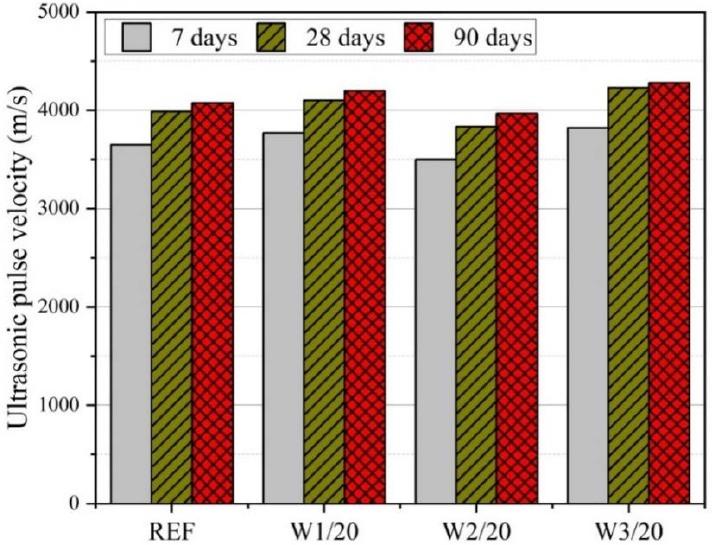
Figure 8. UPV test results for mortar specimens.